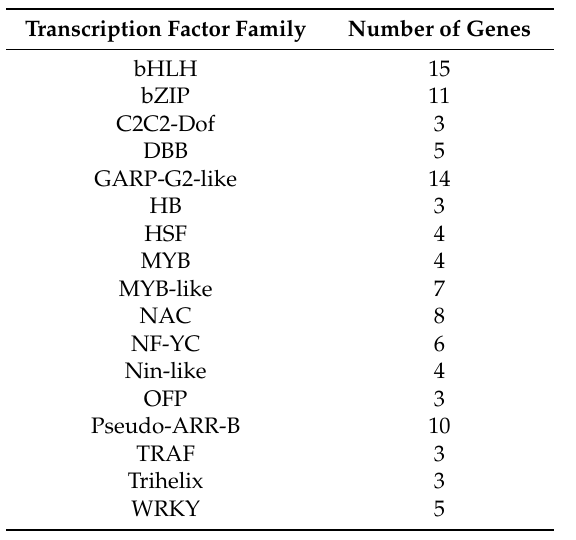
Table S5). For example, gene m.39376, a homolog of sodium/hydrogen exchanger 2 (AT3G05030, CPA), m.138034, a homolog of Ca 2+ -transporting ATPase (AT2G41560), and m.54854, a homolog of